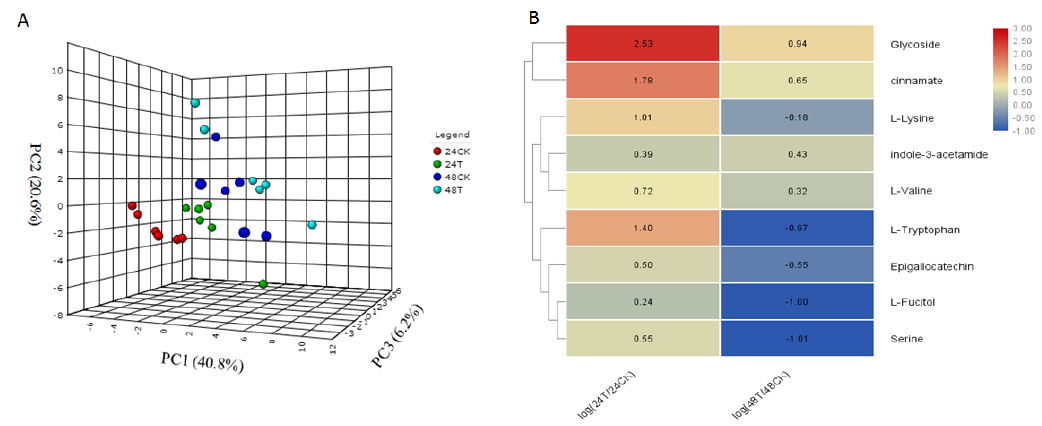
Figure 4. PLSDA and the changes in metabolite profiles in P. acerifolia leaves in response to C. ciliata feeding damage. A . PLSDA of 50 metabolites. B . Changes in nine significantly different metabolites between the 24 and 48 h treatments and controls. The numbers in the heat map represent the log values of the ratios between treatments and controls.